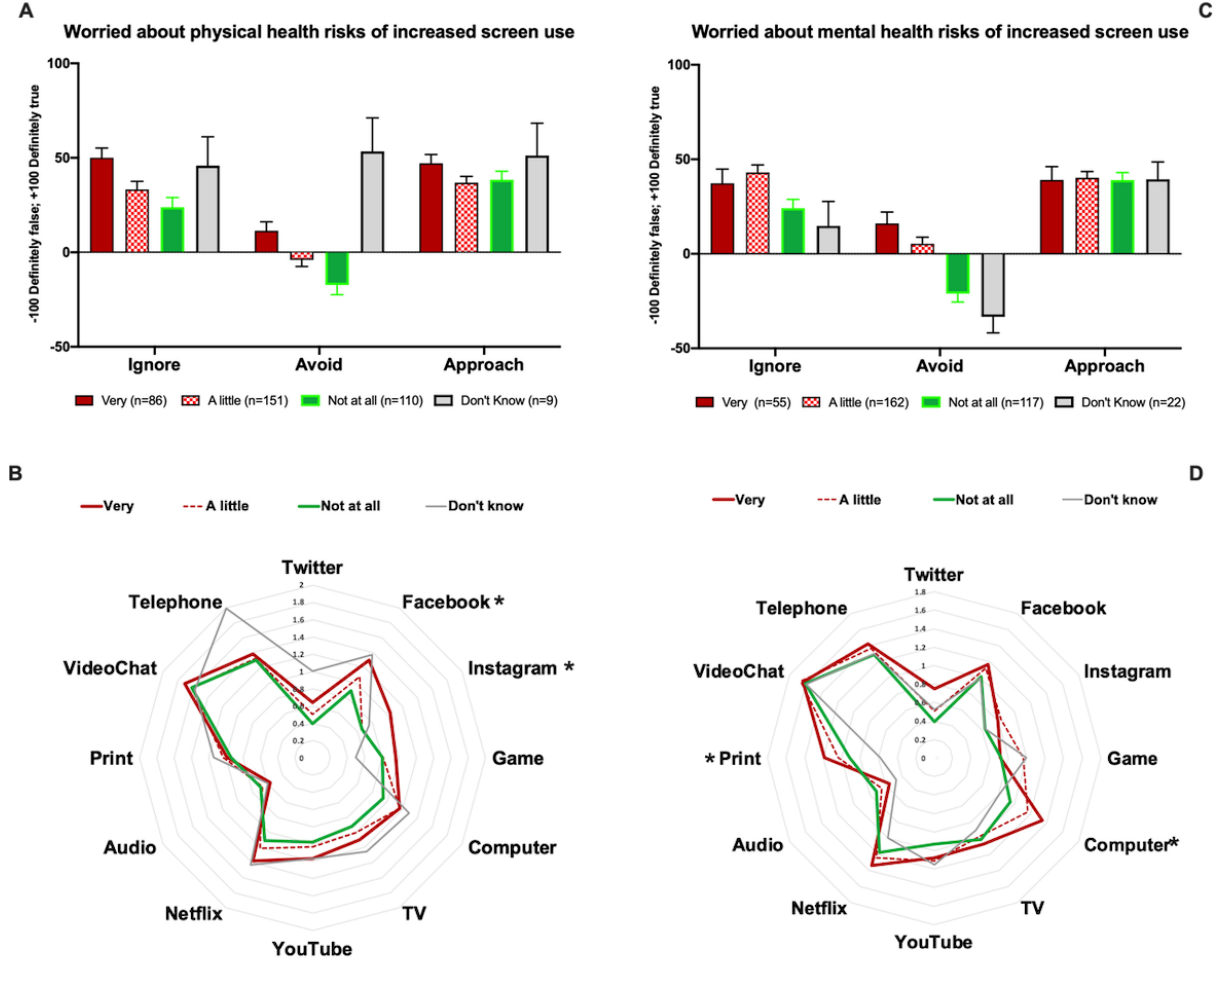
Figure 6. Relation between media appraisal, media use, and perceived risk of mental and physical health deterioration as a result of increased media use. * shows media types whose usage was significantly different between groups ( P